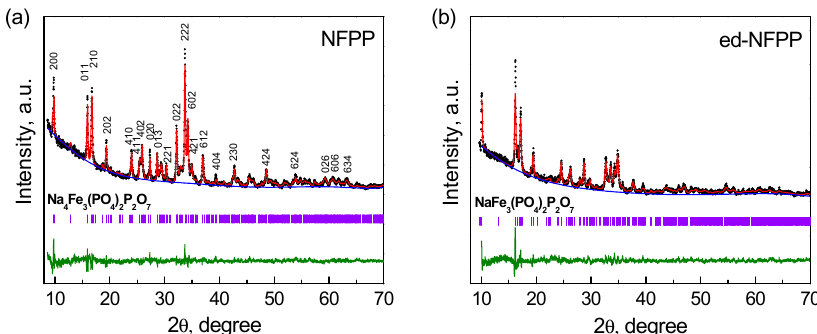
Figure 1. XRD patterns of the pristine Na 4 Fe 3 (PO 4 ) 2 P 2 O 7 (NFPP) ( a ) and of the electrochemically de-sodiated NFPP (ed-NFPP) sample ( b ).